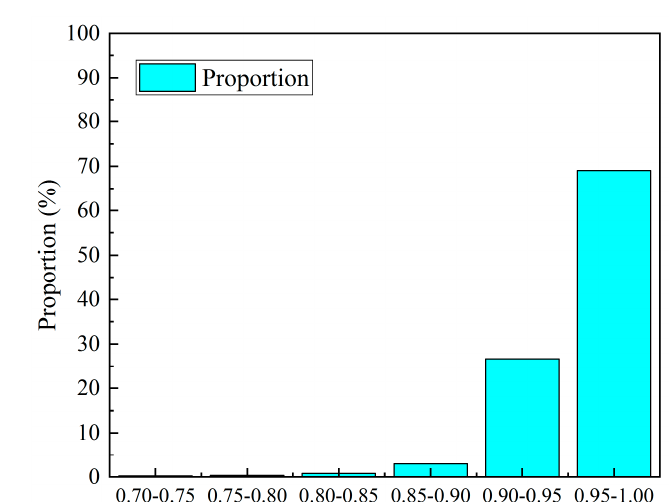
Figure 2. Mesh generation.